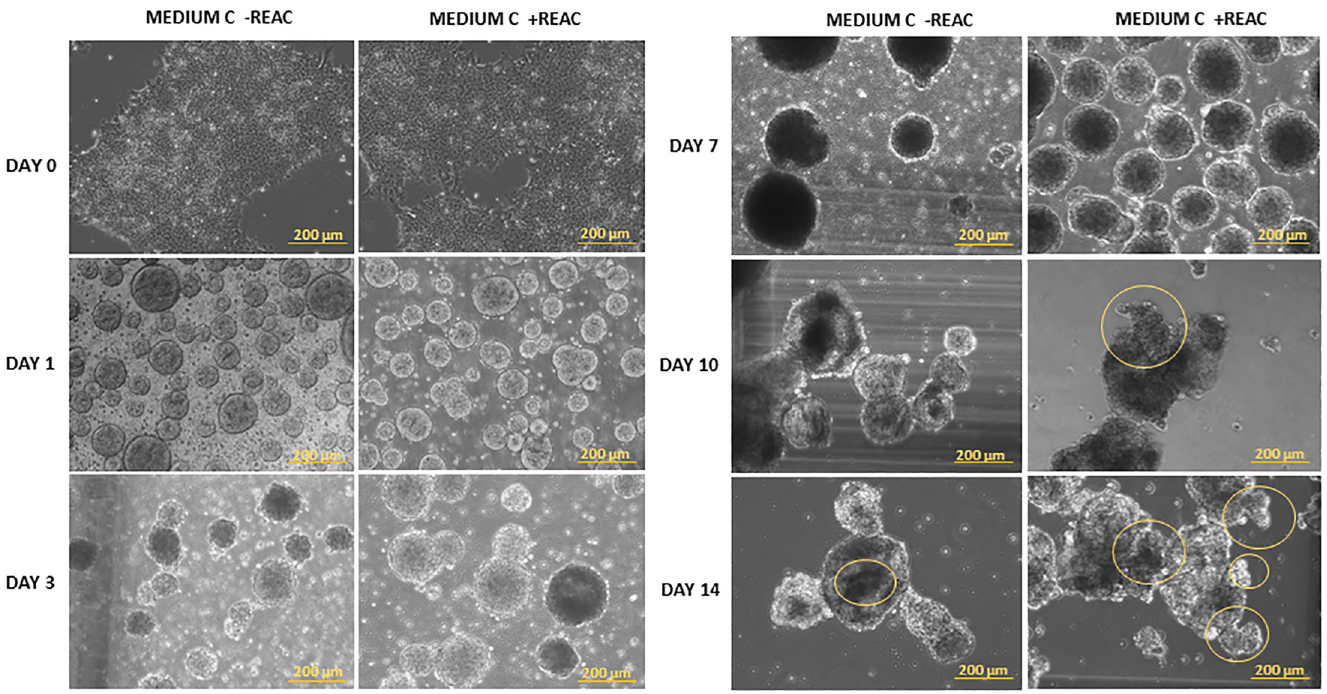
Fig 1. Representative morphologycal evaluation of hUiPSCs over the time in supplemented defined medium and REAC. hUiPSC at day 0 and during the differentiation, culturing in 3D condition in cardiogenic conditioned medium in the absence (Medium C-REAC) or presence of REAC (Medium C+REAC). The yellow circles in the pictures represent the beating cluster zones. The yellow scale bars are 200 μ m.